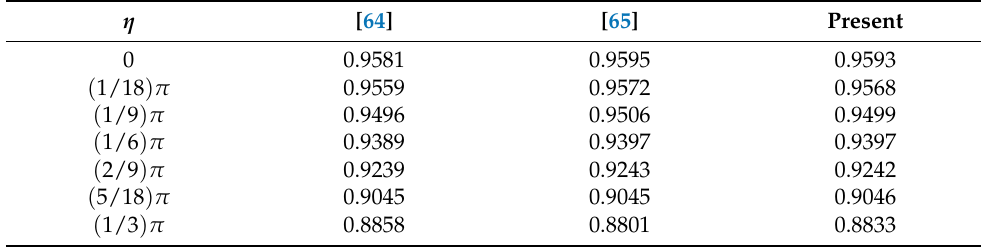
Table 2. Comparison of the outcomes for Nu at Pr = 7, (cid:118) 1 = (cid:118) 2 = 0, We = 0, and M = 0. η [64] [65] Present